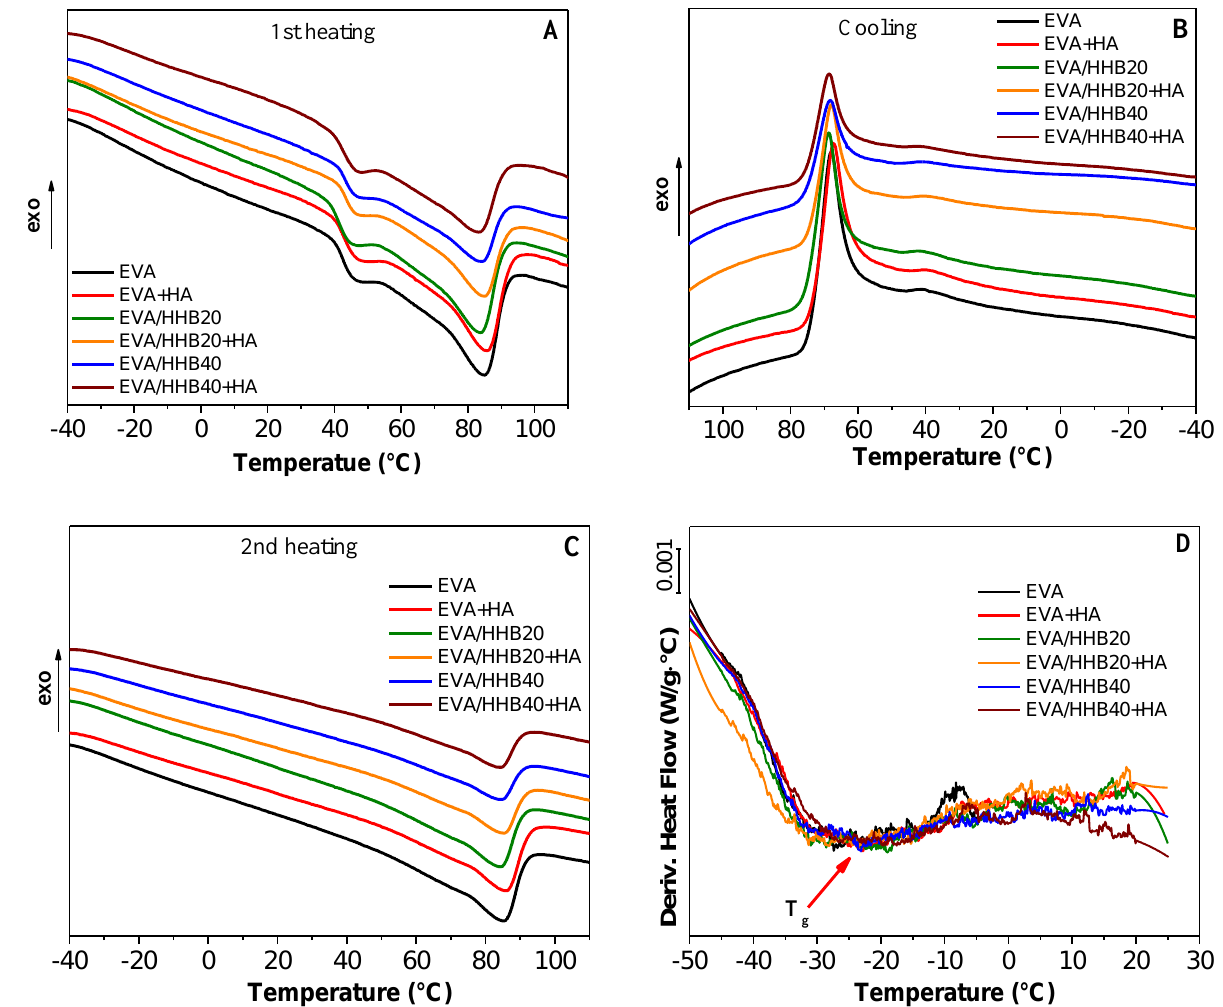
Figure 4. DSC curves of EVA and its composites ( A ) from −40 °C to 110 °C ( B ) from 110 °C to −40 °C and ( C ) from −40 °C to 110 °C (heat flow rate: 10 °C/min). ( D ) First derivative of the 1 st heating run.